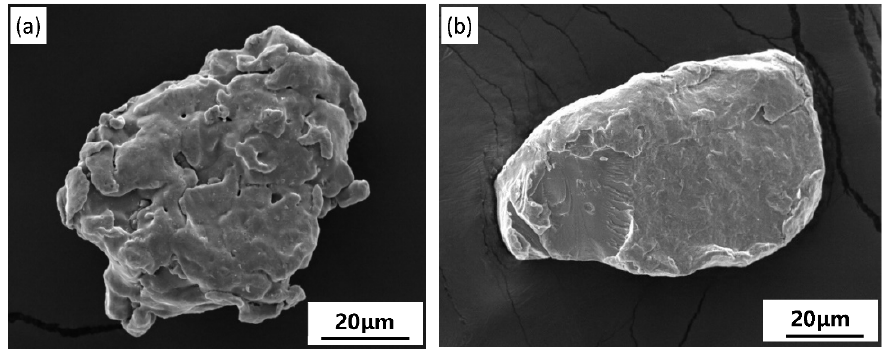
Figure 3. Typical morphology of the Fe and Cr particles: ( a ) Fe particle and ( b ) Cr particle. Micrographs of the Cu–Fe composite are shown in Figure 4a, which indicates that the grey Fe particles were uniformly distributed in the matrix. Figure 5b provides further illustrations of the Fe/Cu interface. Notably, a tightly bonded interface formed between the Fe phase and Cu matrix because of the excellent wettability between them. Nevertheless, a small number of microvoids with high curvature were present on the interface owing to vacancy aggregation, which is caused by the Kirkendall